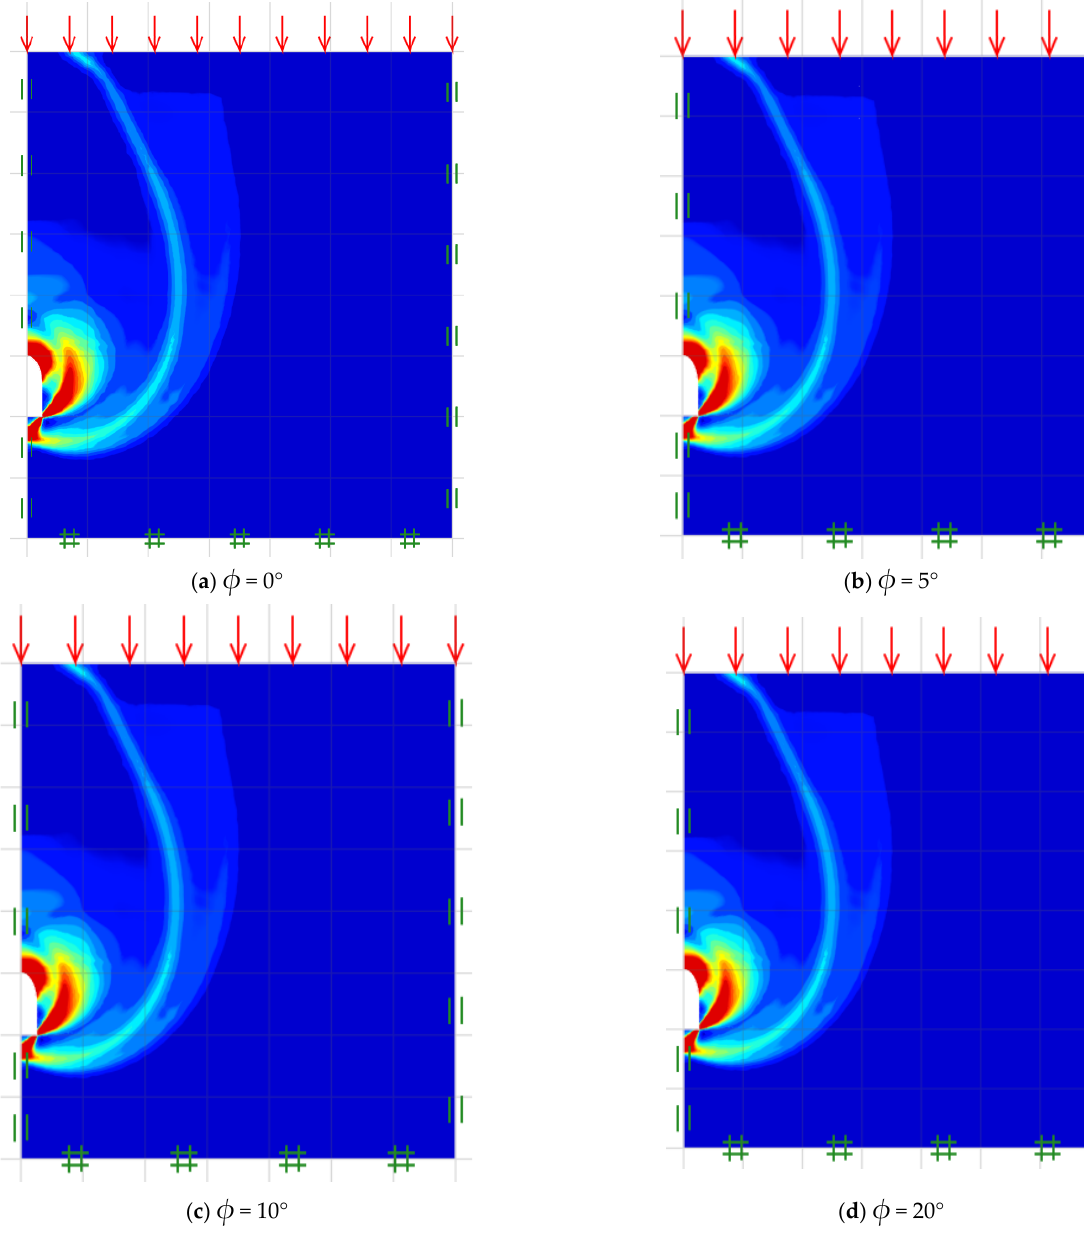
Figure 9. Shear dissipations for various ϕ ( C/D = 5, B/D = 0.5 and γ D/c' = 0).